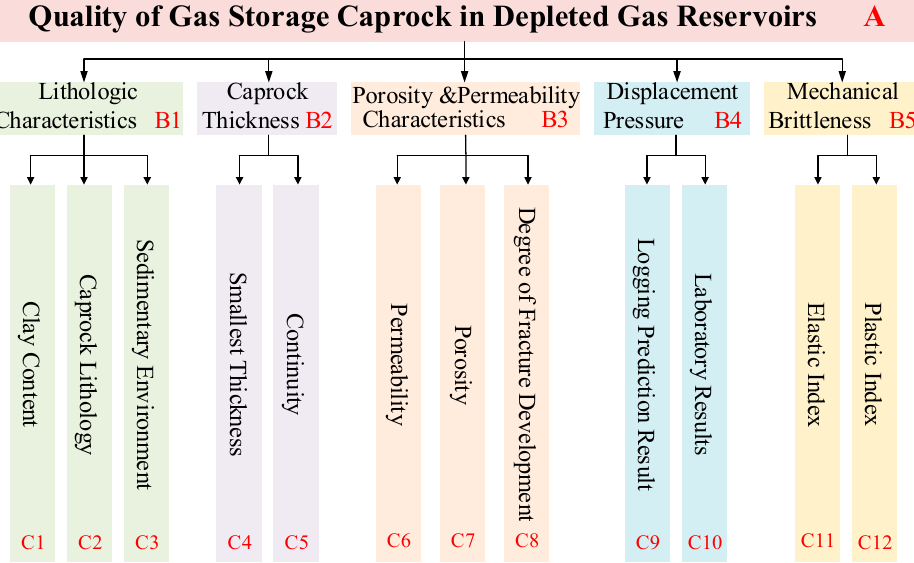
Figure 6. Hierarchical structure model of comprehensive evaluation index of gas storage caprock quality of the depleted gas reservoir.